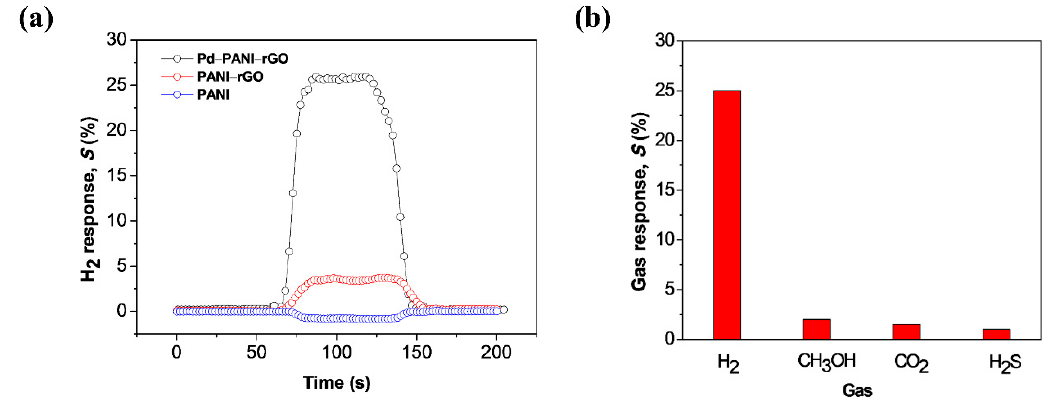
Figure 3. ( a ) Responses of the rGO, PANI, PANI–GO, and Pd–PANI–GO for hydrogen sensing (1%) at room temperature; ( b ) Response of the Pd-PANI-GO-nanocomposite-based sensor to various gases [70] . Copyright (2020), with permission from Elsevier.